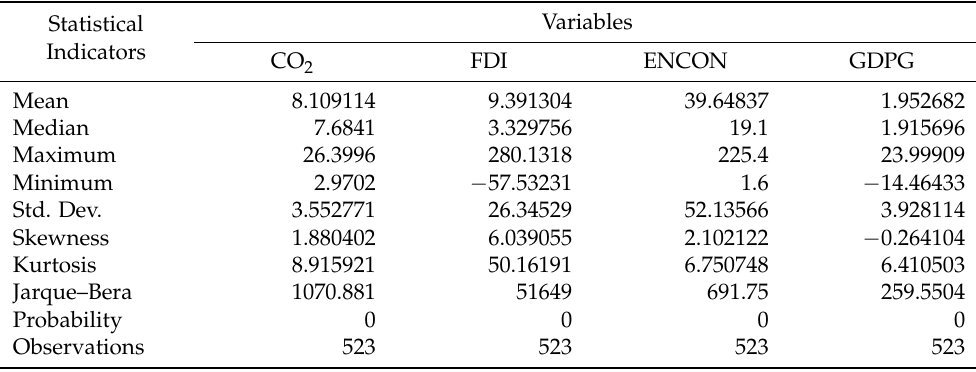
Table 2. Descriptive statistics for each research